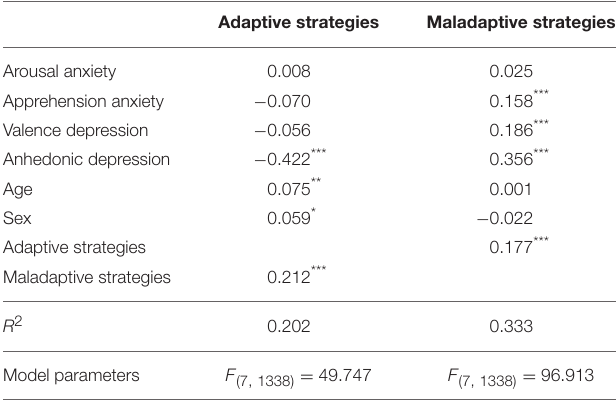
TABLE 6 | Results of regression analyses (standardized Betas) for the predicted aggregated adaptive and maladaptive cognitive emotion regulation strategies (CERS) with types of anxiety and depression, age, sex, and the aggregated maladaptive and adaptive CERS (respectively) as predictors ( N =